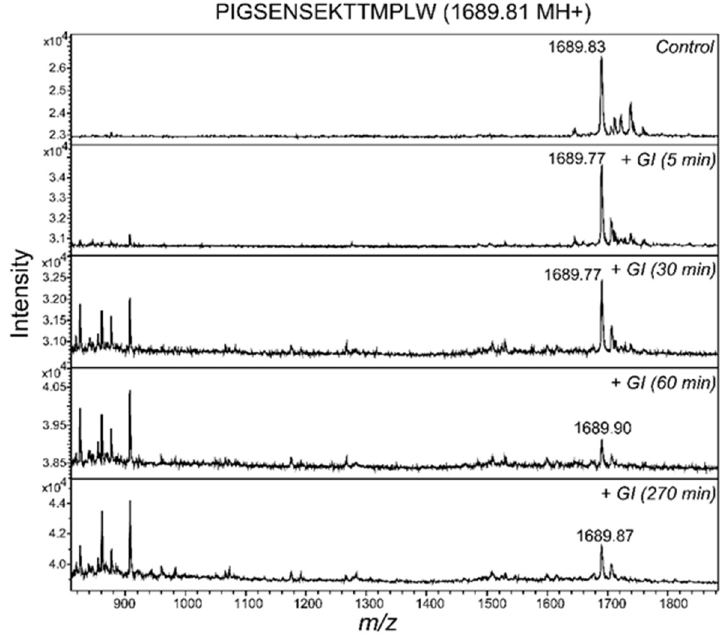
Figure 5. In vitro gastrointestinal digestion (GI) of the PIGSENSEKTTMPLW peptide. The synthetic PIGSENSEKTTMPLW peptide was incubated with pepsin and subsequently with trypsin, chymotrypsin and elastase (for 5 min, 30 min, 60 min and 270 min) to simulate GI digestion. The digests were analyzed by matrix-assisted laser desorption ionization time-of-flight mass spectrometry (MALDI-MS).